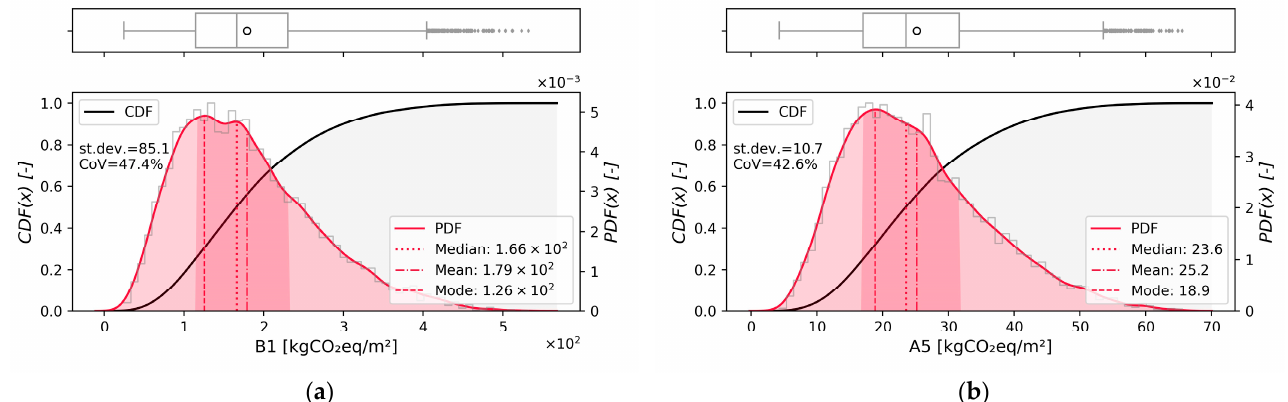
Figure 12. PDFs, CDFs, and box-whisker plots for the GWP related to relevant stages for: ( a ) A-S1; ( b ) B-S1. The EoL and A5 results are not reported, since they are negligible and equal to zero, respectively.